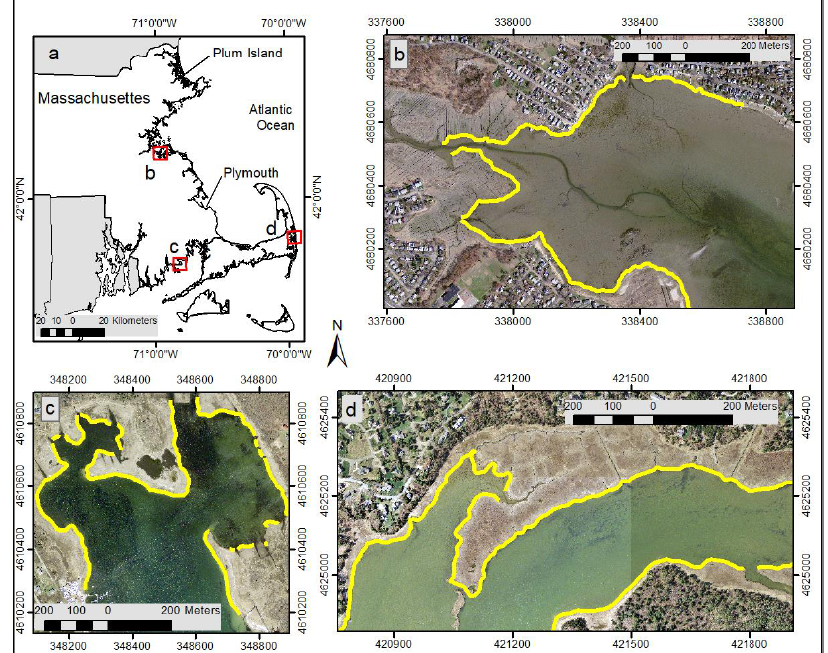
Figure 1. ( a ) Coastal Massachusetts, ( b ) Broad Meadows Marsh in Quincy, ( c ) Brant Island Cove in Buzzards Bay, ( d ) Pleasant Bay in Orleans. Yellow line in (b–d) shows marsh scarp from marsh edge from elevation data (MEED) using lidar data. Imagery from the U.S. Geological Survey (USGS).